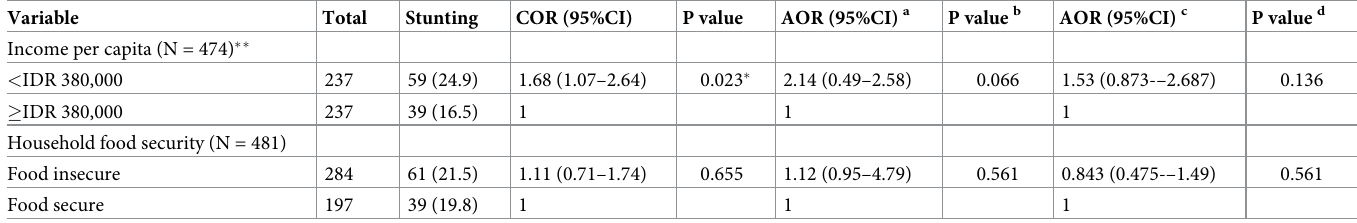
Table 5. Household characteristics and